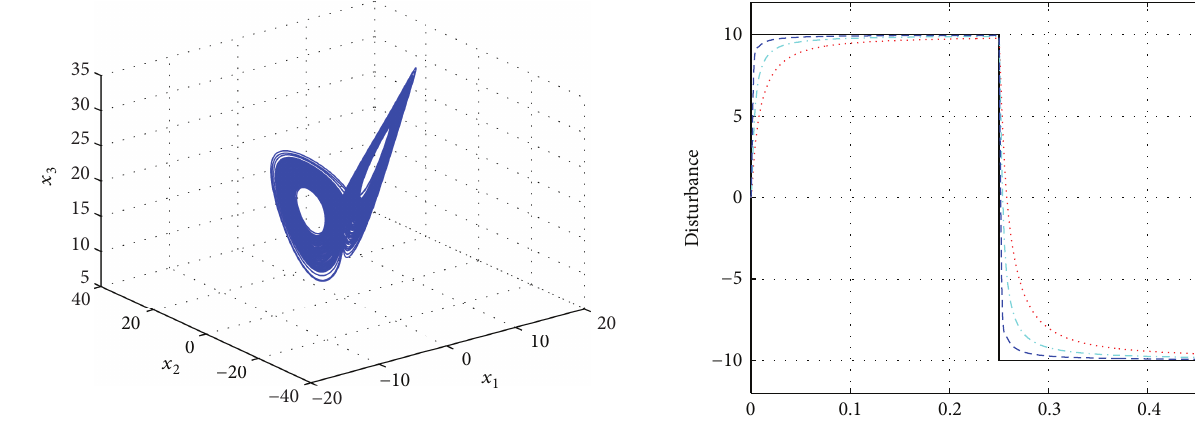
Figure 1: Chaotic attractor of the system with 𝑑(𝑡) = 0 .